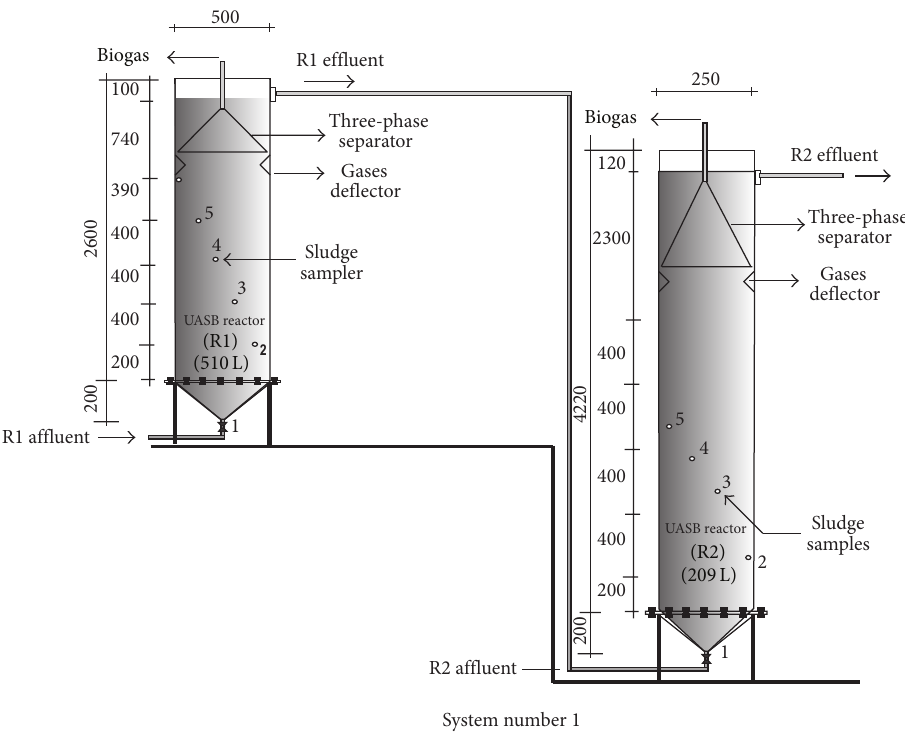
Figure 1: Schematic diagram of the experimental facilities of anaerobic treatment system I (I), with two UASB reactors, placed in series, at pilot scale. Source: Oliveira and Santana [16].